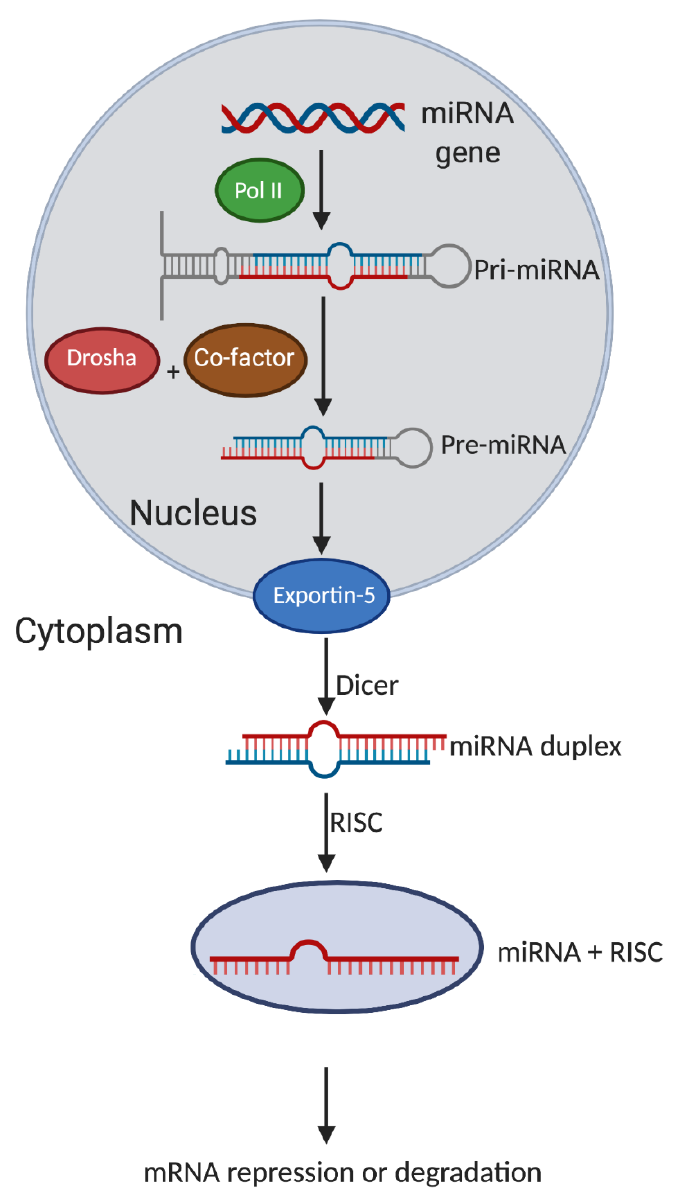
Figure 1. A schematic illustration of miRNA biogenesis and mechanism of action. miRNA gene is transcribed by RNA polymerase II into primary miRNA (pri-miRNA). Pri-miRNAs are then processed in the nucleus by an enzyme named Drosha which has an RNAse III domain and a co-factor into miRNA precursors (pre-miRNAs). The pre-miRNAs are exported from the nucleus to the cytoplasm by Exportin-5 and co-factor RAN-GTP. The hairpin structure of pre-miRNA is cleaved off by Dicer to produce the miRNA duplex. RNA inducing silencing complex (RISC) binds with the long messenger RNA (mRNA) and can subsequently either repress or degrade mRNA.